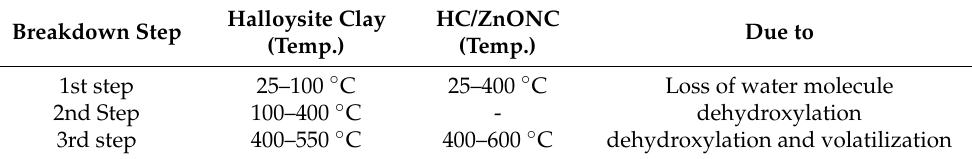
Figure 12. TGA analysis of Halloysite clay, ZnO and HC-ZnONC. Table 3. TGA details of HC, ZnONPs and